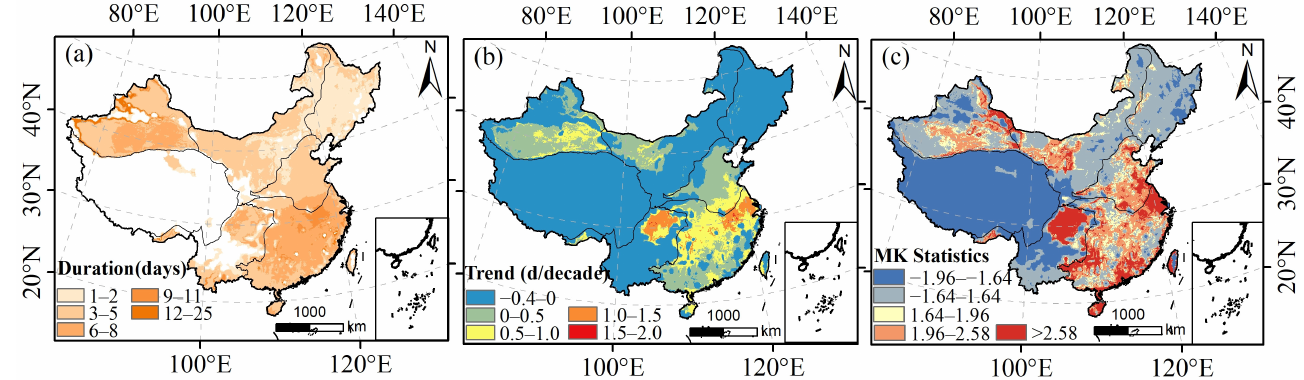
Figure 13. The spatial distribution of ( a ) different mean durations of heatwave events, ( b ) interannual change trend, and associated ( c ) Mann–Kendall statistics during 1978–2018.